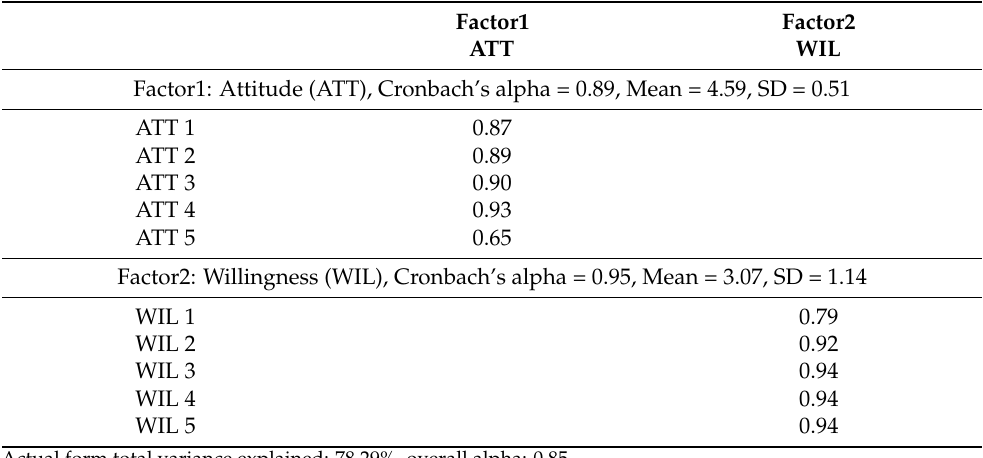
Table 1. Results of EFA for FAA ( N = 207).